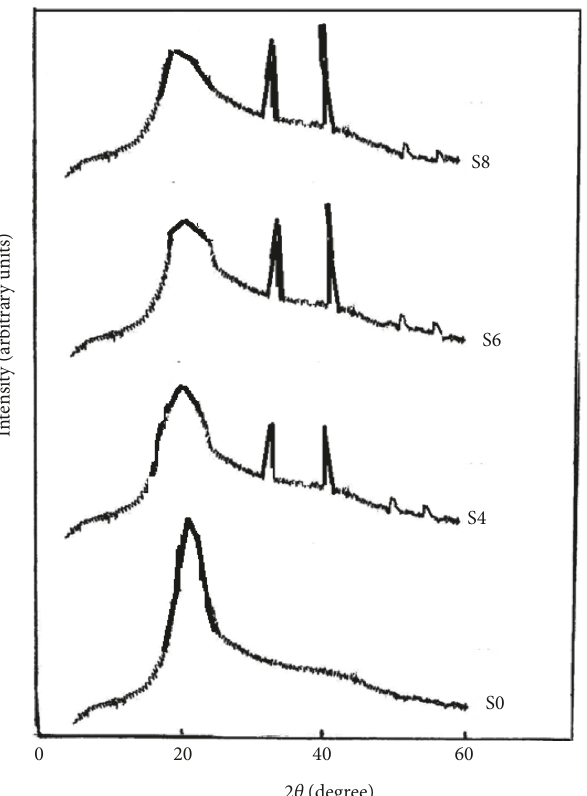
Figure 1: X-ray diffraction profiles of CuONPs-doped HEC